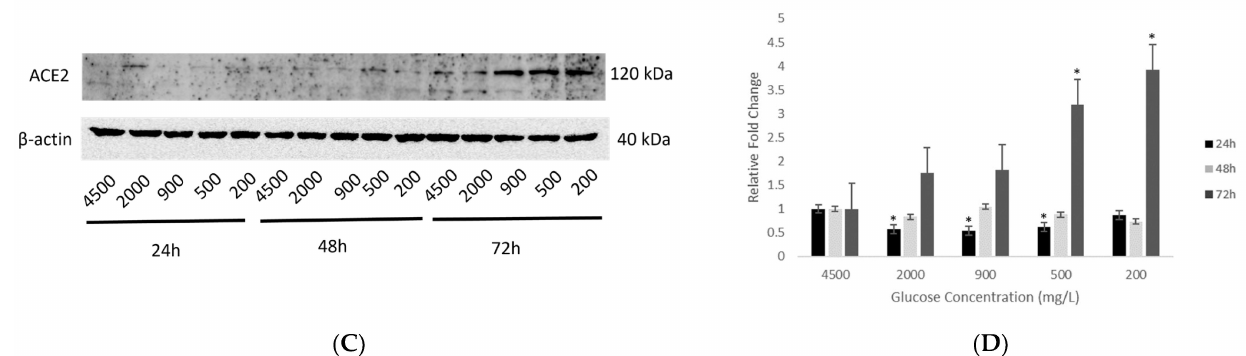
Figure 3. Protein expression of ACE2 in hypothalamic neurons under various glucose concentrations at different time points. ( A ) With increasing glucose concentrations (mg/L) of 5400, 10,800, 16,200, and 21,600, ACE2 (120 kDa) showed an upward trend in protein expression, with significant upregulation ( p < 0.05) observed at the highest concentration of 21,600 mg/L after 72 h exposure as compared to the control condition (4500 mg/L). ( B ) Histogram with relative fold change for ACE2 (cid:48) s protein expression ( n = 3) with increasing glucose concentrations compared to loading control ( β -actin; 40 kDa). ( C ) With decreasing glucose concentrations (mg/L) of 2000, 900, 500, and 200, ACE2 (cid:48) s protein expression increased significantly ( p < 0.05) at longest exposure of 72 h and at the lowest concentrations of 500 and 200 mg/L glucose, as compared to the control condition (4500 mg/L). ( D ) Histogram with relative fold change for ACE2 (cid:48) s protein expression ( n = 3) with decreasing glucose concentrations compared to loading control ( β -actin). Data is represented as mean ± SEM (* p < 0.05). Full blot images are provided in Supplementary Materials (Figures S1 and